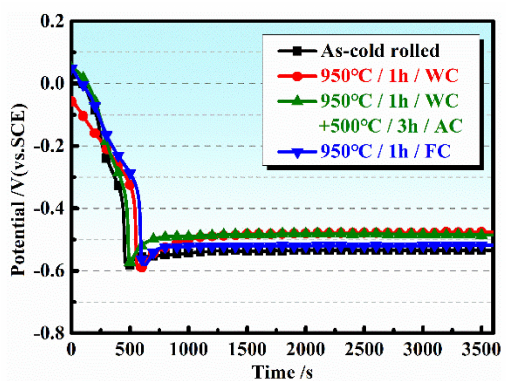
Figure 3. OCPs of as − cold rolled and solid solution treated sheets versus immersion time in naturally aerated 0.5 M H 2 SO 4 + 5 ppm F − solution at 80 ◦